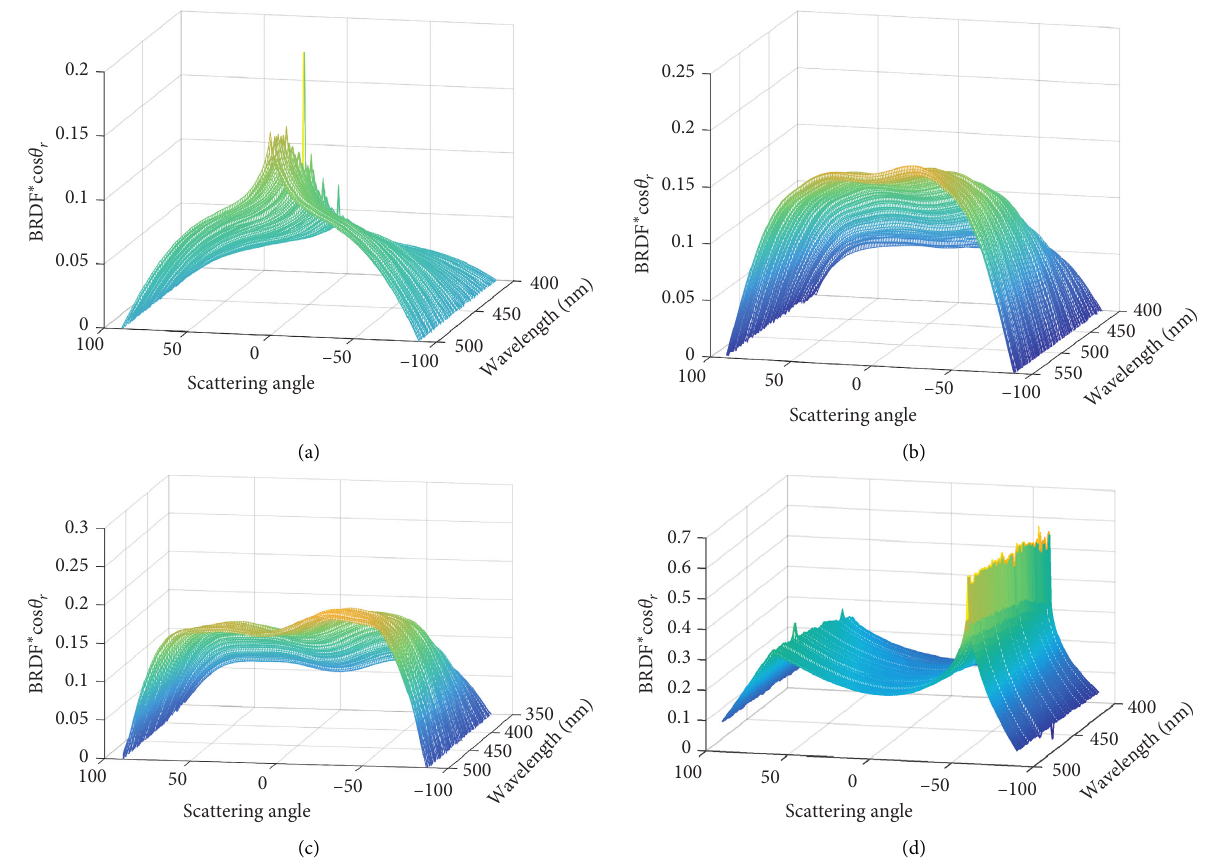
Figure 4: Fitted 3D graph of the Martian soil. (a) Fitted 3D graph of the 0 ° incident angle; (b) fitted 3D graph of the 30 ° incident angle; (c) fitted 3D graph of the 45 ° incident angle; (d) fitted 3D graph of the 60 ° incident